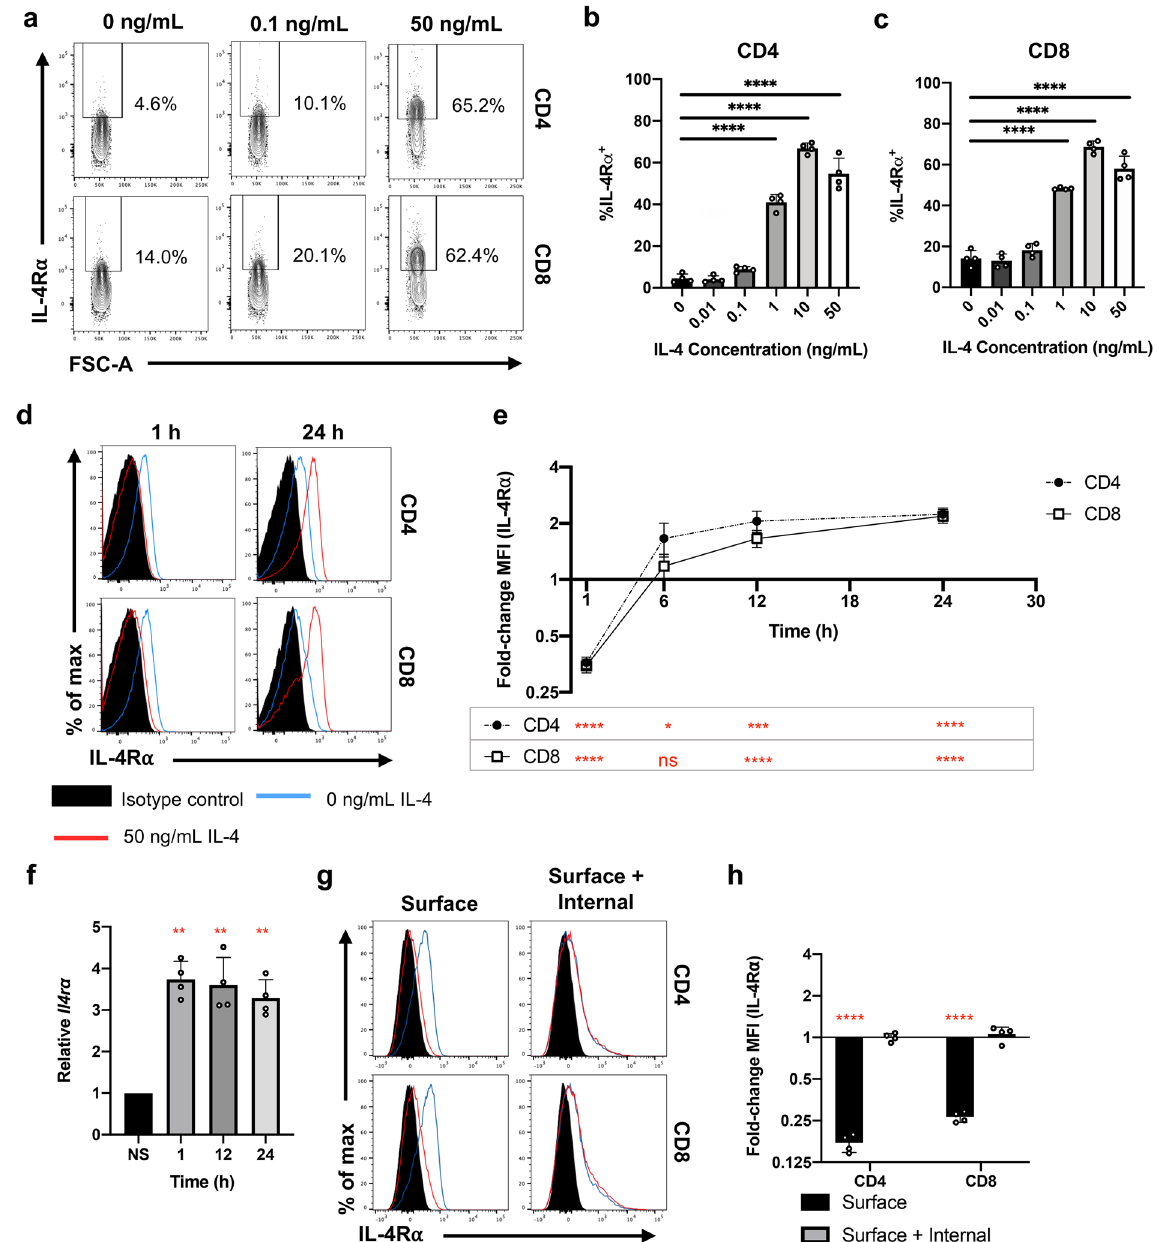
Figure 1. IL-4 stimulation modulates the expression of IL-4R ⍺ . Whole spleen homogenate derived from naïve 6–8-week-old female BALB/c mice ( n = 4) were stimulated with recombinant IL-4 in vitro prior to flow cytometric analysis. (a) Representative contour plots showing the expression of IL-4R ⍺ on pre-gated CD4 and CD8 T cells treated with variable IL-4 concentrations for 24 h. The proportion of both (b) CD4 and (c) CD8 T cells deemed IL-4R ⍺ + . (d) Representative histograms showing the distribution of IL-4R ⍺ expression on pre- gated T cells following 50 ng/mL IL-4 stimulation for 1–24 h. (e) Fold-change in MFI (IL-4R ⍺ ) with respect to time. (f) 100 CD3 + CD4 + CD8 - IL-4R ⍺ + cells were sorted following 50 ng/mL IL-4 stimulation and qPCR was conducted to measure the transcript levels of Il4ra , Ct values are normalised the endogenous L32 control and represented as 2 -ΔΔCt according to the respective non-stimulated (NS) control. (g) Representative histograms comparing the surface and total (surface and internal) IL-4R ⍺ following 1 h IL-4 stimulation. Notably, total cell IL-4R ⍺ was measured by staining after fixation and permeabilisation. (h) Fold-change MFI (IL-4R ⍺ ) between cells treated with and not treated with IL-4. Data are represented as mean + SD, with dots representing biological replicates from a single experiment. The experiments were at least repeated at least twice. One-way ANOVA combined with a post-hoc pairwise comparison was conducted (using Prism 8) (black). Paired two-way t-tests were conducted to establish statistical significance in fold-change MFI (red) under each condition. p -value denotations: ‘ns’ p ≥ 0.05, ‘*’ p < 0.05, ‘**’ p < 0.01, ‘***’ p < 0.001 and ‘****’ p <